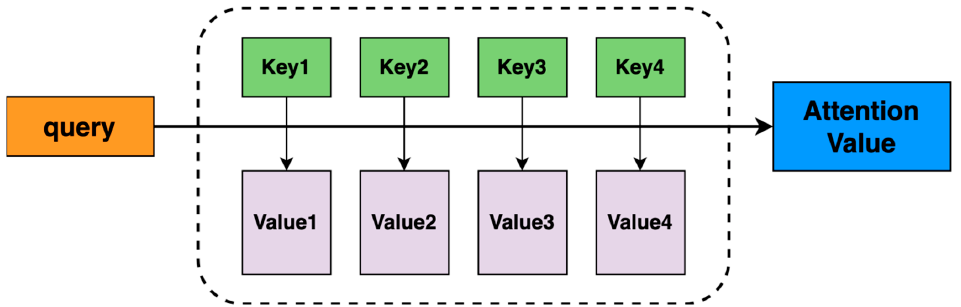
Figure 2. The calculation process of attention